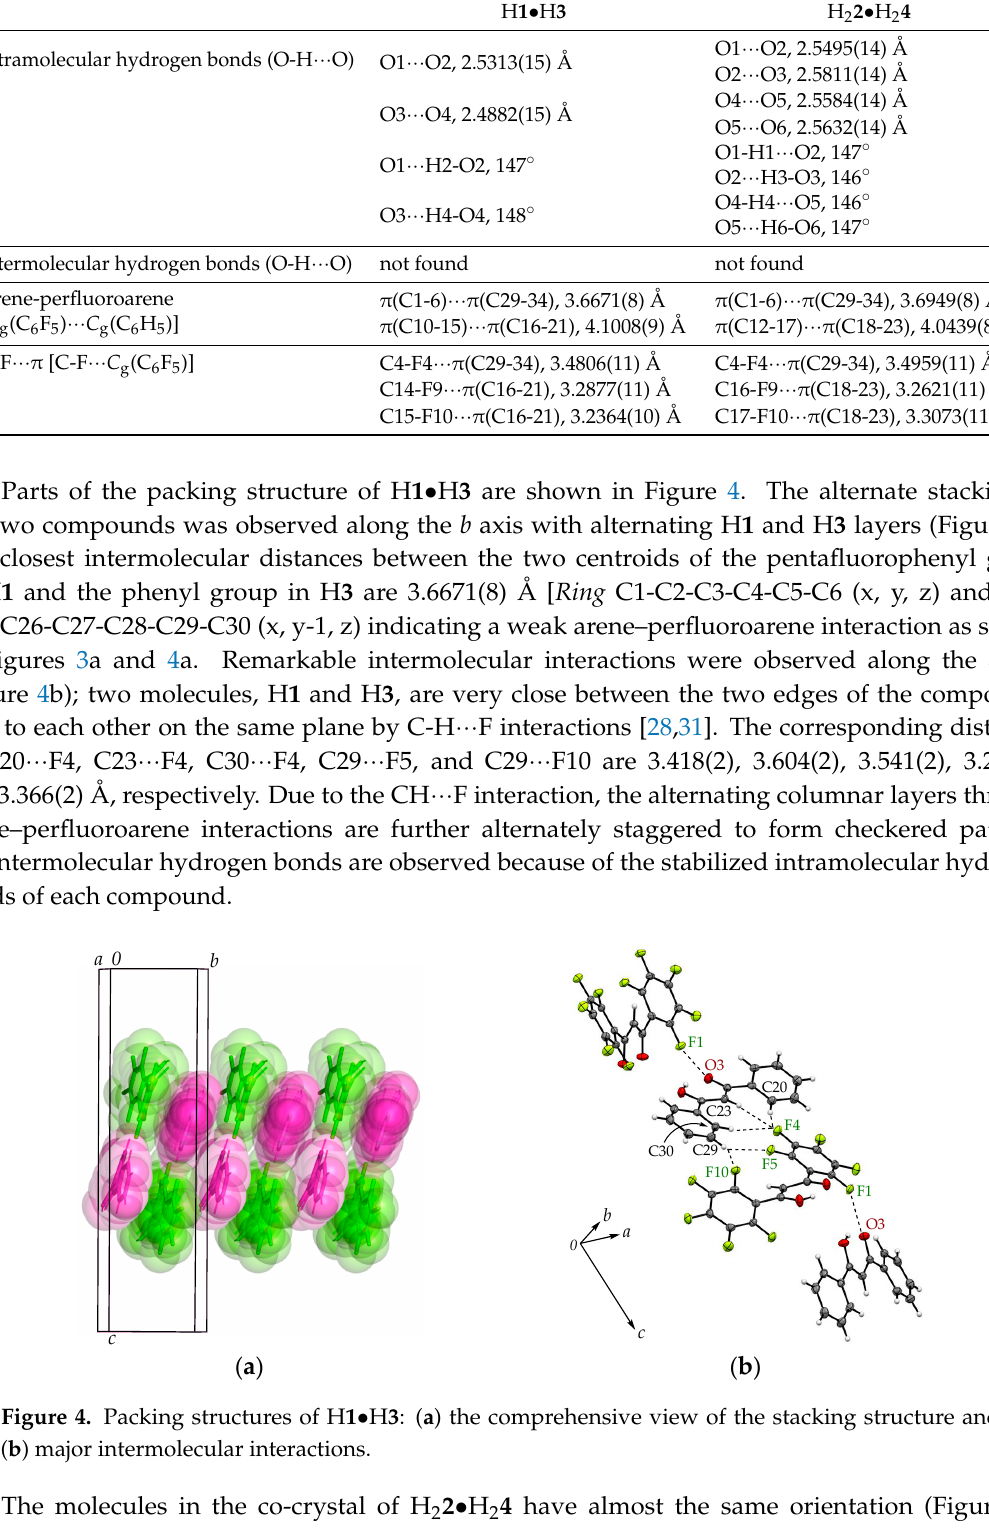
Table 2. Major intra- and intermolecular interactions of H 1 •H 3 and H 2 2 •H 2 4 .